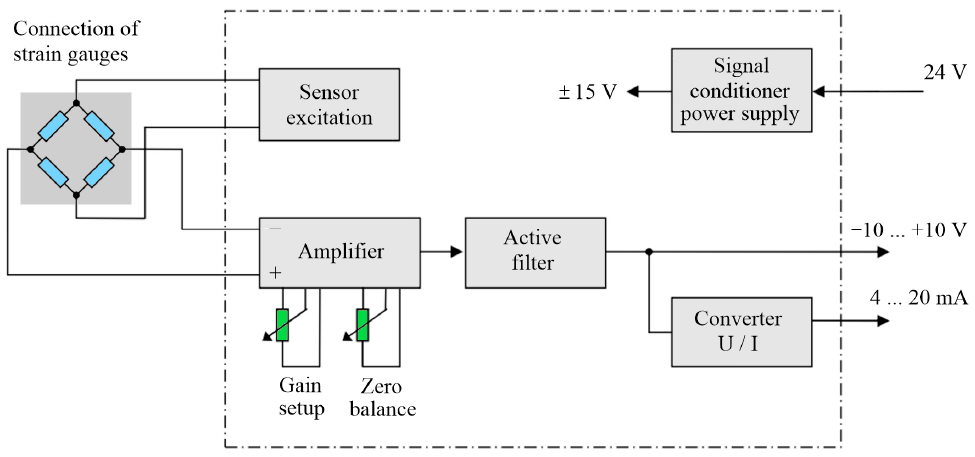
Figure 9. Block diagram of the EMS170 converter.